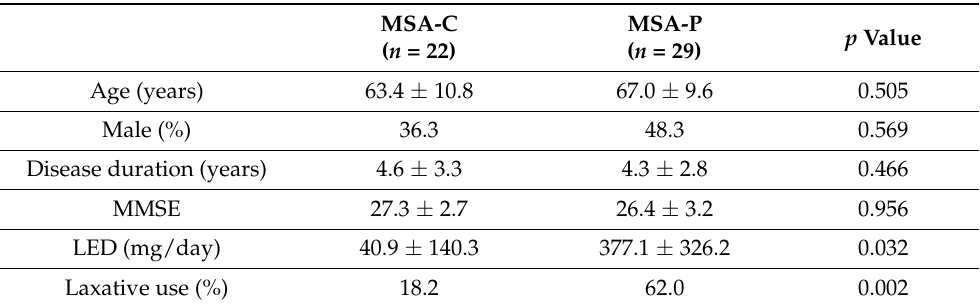
Table 4. Comparison of demographic and clinical characteristics among groups of MSA-C and MSA-P.